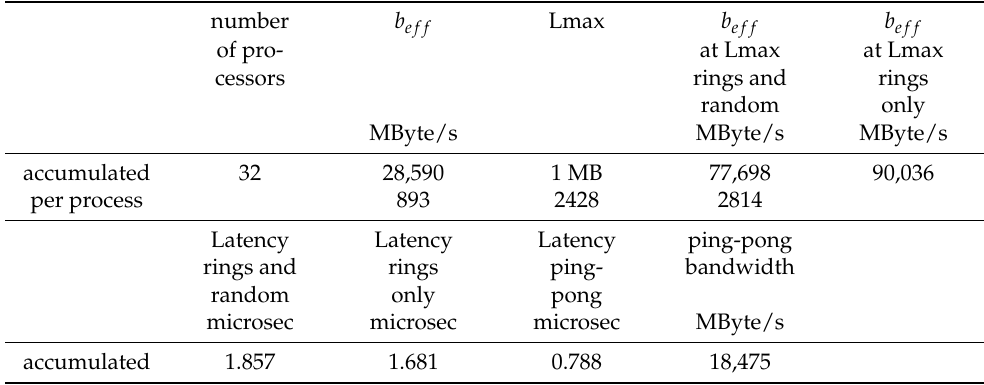
Table 2. Bandwidth with 32 core.